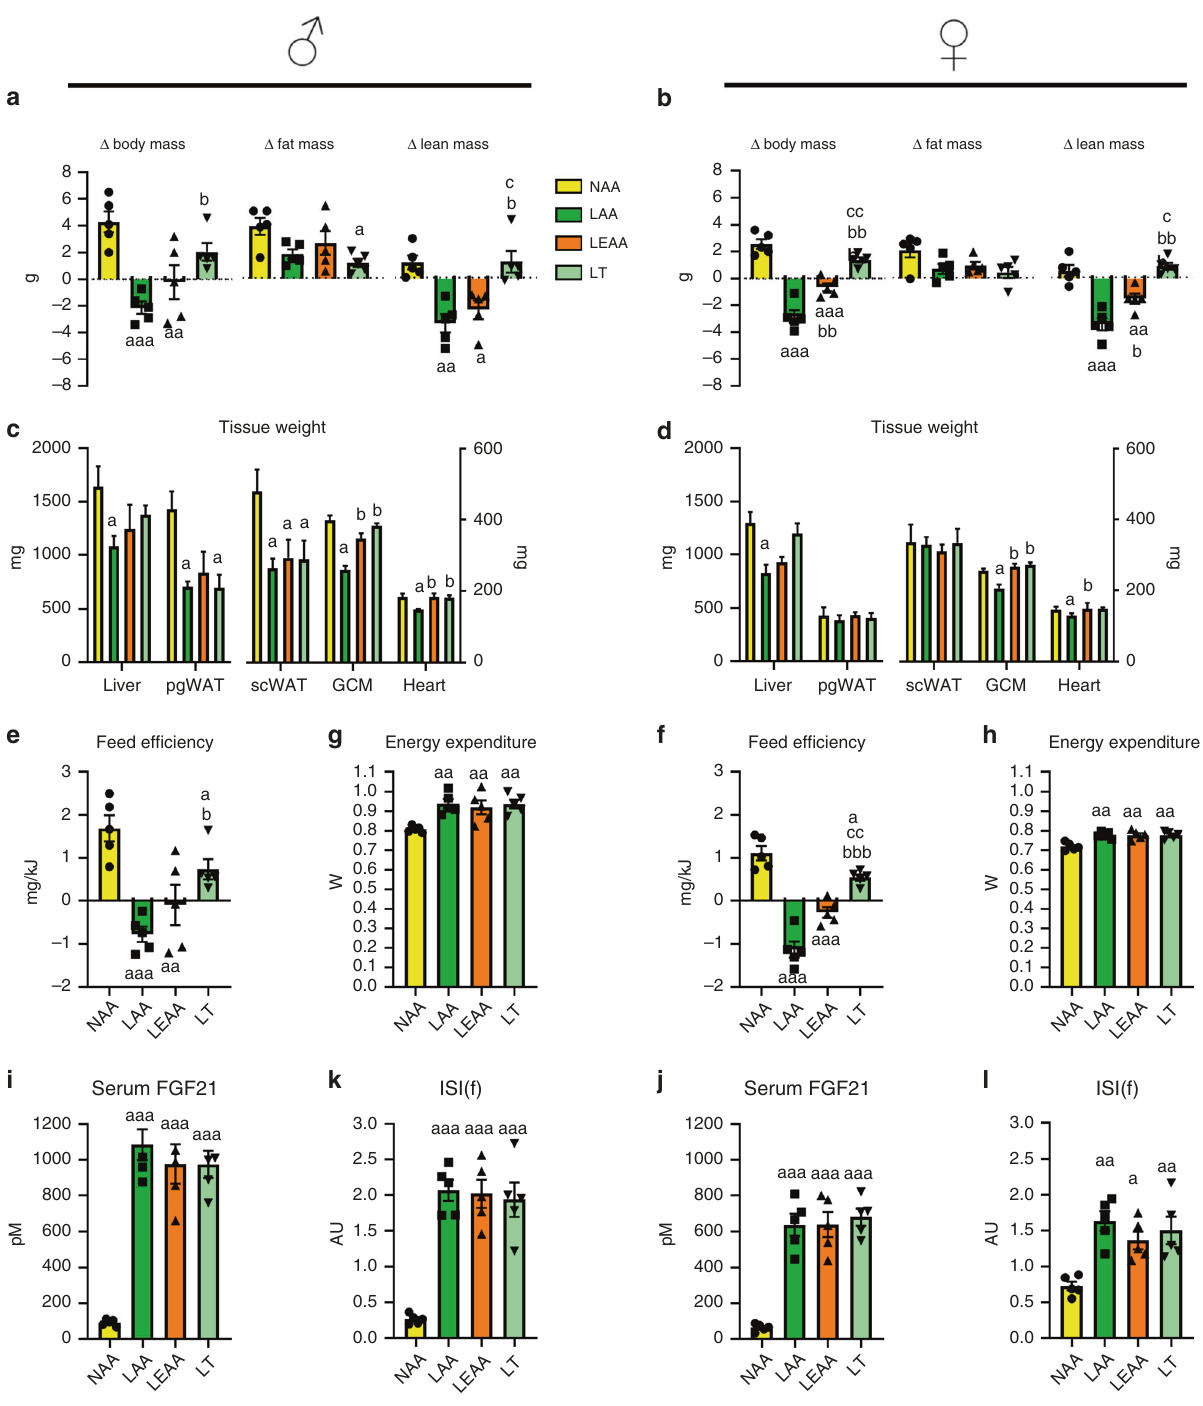
Fig. 4 The systemic metabolic response to dietary AA restriction is conserved in mature male and female mice. a The change in body, fat, and lean mass of 6-month-old male (shown left) mice in response to an 8-week treatment with diets containing 18% from amino acids (normal amino acid; NAA), 4.5% AA (LAA; as of diet B in Fig. 2c), 4.5% essential AA (LEAA; as of diet E in Fig. 2c), and a diet low in threonine but with matching total AA to NAA (LT). Data are mean and SEM ( n = 5 individual mice per group). Data were analysed by one-way ANOVA with Holm – Sidak post-hoc tests. Different than NAA: a P < 0.05, aa P < 0.01, aaa P < 0.001. Different than LAA: b P < 0.05, bb P < 0.01, bbb P < 0.001. Different than LEAA: c P < 0.05, cc P < 0.01, ccc P < 0.001. b The change in body, fat, and lean mass of 6-month-old female (shown left) mice treated as in ( a ). c Tissue weights of mice at the end of the treatment as in ( a ). d Tissue weights of mice at the end of the treatment as in ( b ). e Feed ef fi ciency during the 8-week treatment of mice as in ( a ). f Feed ef fi ciency during the 8-week treatment of mice as in ( b ). g Energy expenditure of mice as in ( a ). h Energy expenditure of mice as in ( b ). i Serum fi broblast growth factor 21 (FGF21) levels of mice as in ( a ). j Serum FGF21 of mice as in ( b ). k Insulin sensitivity index during fasting (ISI(f)) of mice as in ( a ). l ISI(f) of mice as in ( b